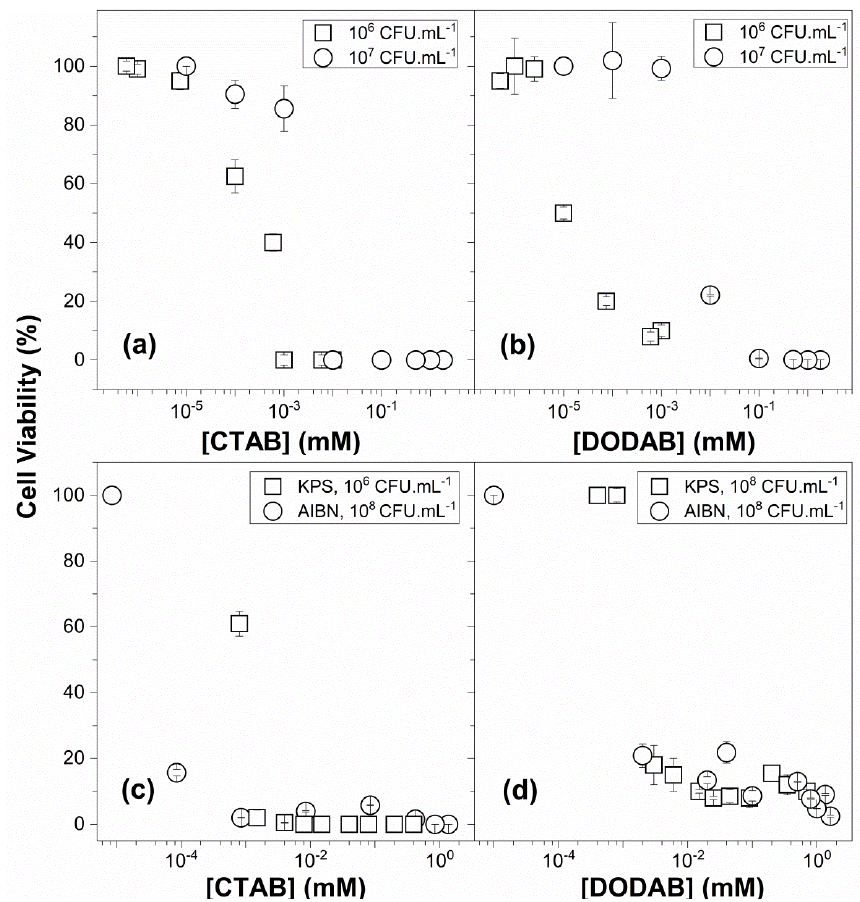
Figure 8. Candida albicans viability (%) ( ○ ) over a range of CTAB (a) or DODAB concentrations (b) in QAC dispersions in water as compared to data from [31] ( □ ). Staphylococcus aureus viability (%) ( ○ ) over a range of CTAB (c) or DODAB concentrations (d) in the presence of PMMA/QAC NPs, as compared to data from [27] ( □ ). QAC dispersions in water are CTAB micelles or DODAB BF. In (c) and (d), PMMA/QAC NPs were obtained by the emulsion polymerization of MMA in the presence of QACs. These NPs were obtained either using AIBN ( ○ ) or KPS ( □ ) as the initiator. [MMA] and [QAC] used during particle synthesis were 0.56 M and 4.0 mM, respectively, for squares in (c), 0.4 M and 2.0 mM, respectively, for circles in (c) and (d), and 0.56 M and 10 mM, respectively, for squares in (d).